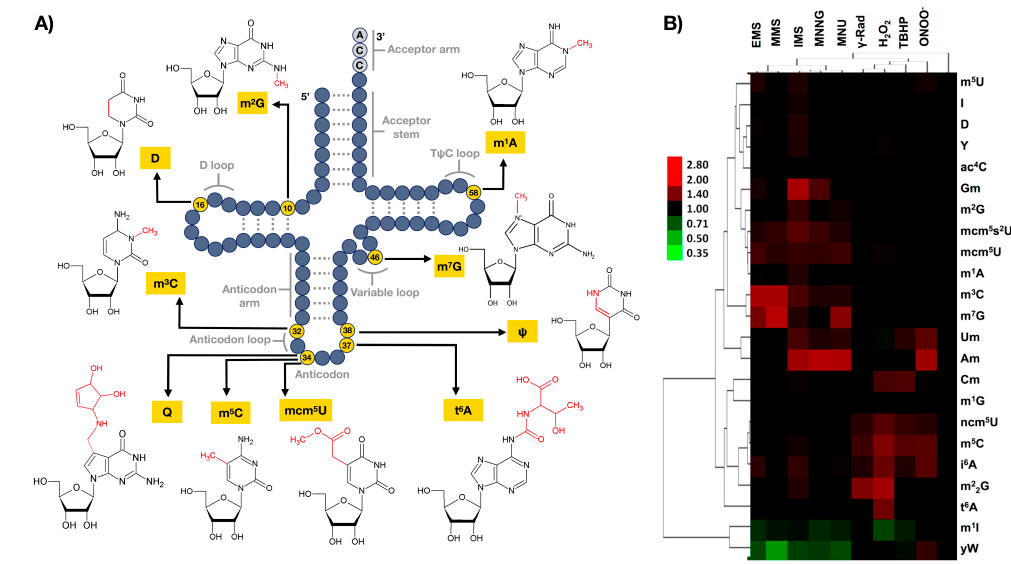
Figure 1. ( A ) Clover-leaf structure of eukaryotic tRNA formed through base pairing in the acceptor stem, D-loop, anticodon arm, and T ψ C-loop. Structures and positions of some modifications discussed in the review are indicated. ( B ) Hierarchical cluster analysis of average fold-change values for tRNA modifications in total tRNA from S. cerevisiae exposed to equitoxic (LD 80 ) doses of various alkylating (EMS, ethyl methansulfonate; MMS, methyl methansulfonate; IMS, isopropyl methanesulfonate; MNNG, N -methyl- N ′ -nitro- N -nitrosoguanidine; MNU, N -nitro- N- methylurea) and oxidizing agents ( γ -Rad, γ -radiation; H 2 O 2 , hydrogen peroxide; TBHP, tert-butyl hydroperoxide; ONOO - , peroxynitrite). Yeast cells were exposed to LD 80 doses of the agents and tRNA